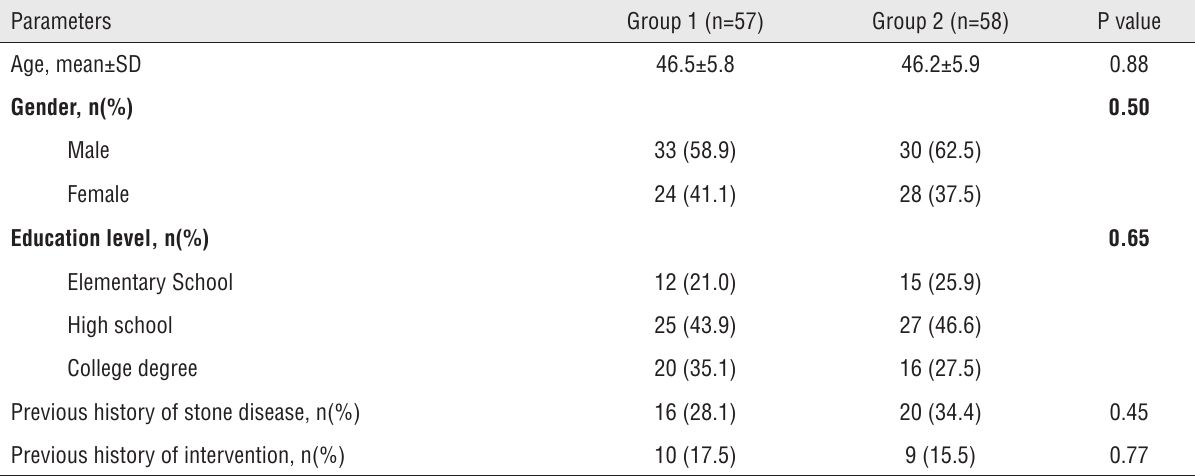
Table 1 - Demographic characteristics and stone disease related history of the patient groups.